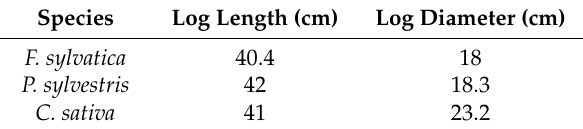
Table 1. Details of stem segments of F. sylvatica , C. sativa and P. sylvestris .